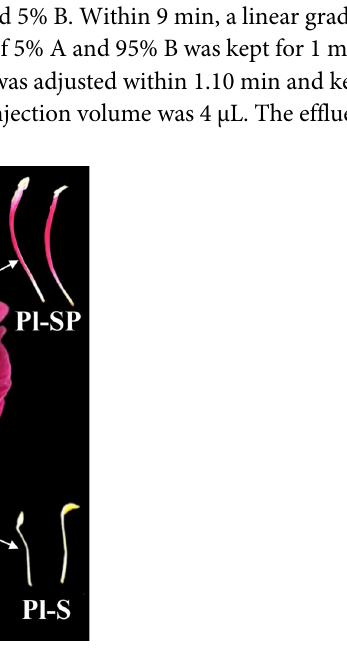
Fig 1. Flower morphology of P . lactiflora